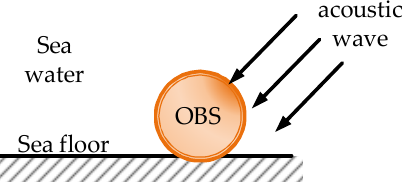
Figure 3. The acoustic wave around the OBS placed on the seafloor.